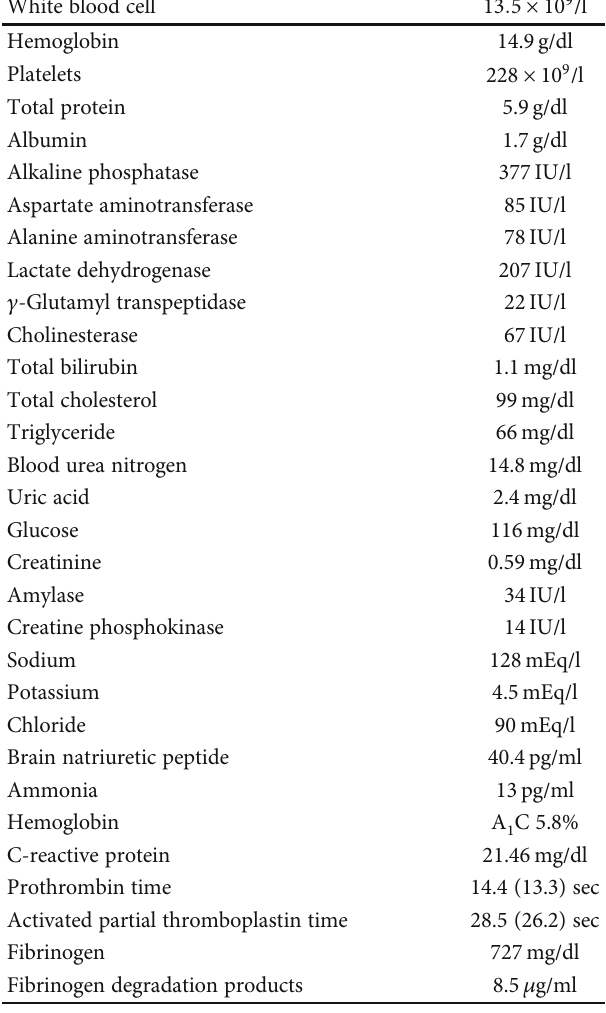
Table 1: Blood test fi ndings on arrival.